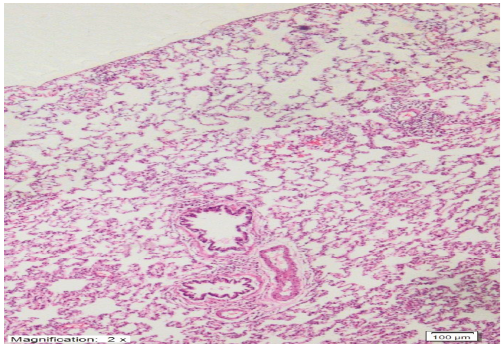
Figure 8: Lung tissue congestion and microscopic histopathological fi ndings were absent in the TG group (H&E ×